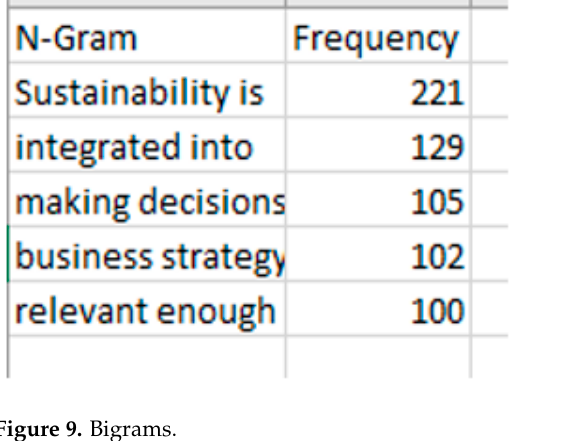
Figure 9. Bigrams. Figure 9. Bigrams.